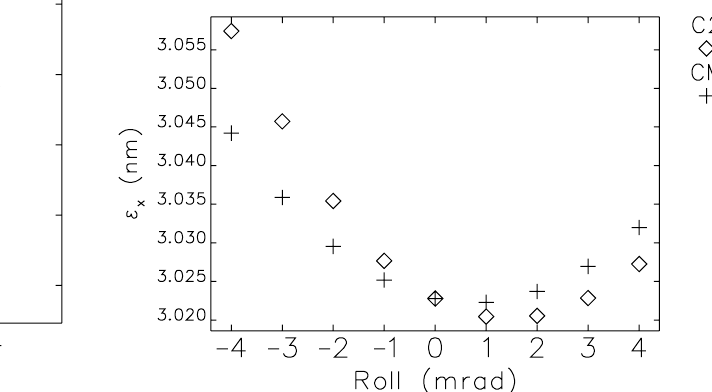
FIG. 17. Eventual horizontal emittance as a function of cavity roll for h (cid:3) 8 and V (cid:3) 4 MV . The ‘‘CM’’ data is for common- mode roll while the ‘‘DM’’ data is for differential-mode roll.